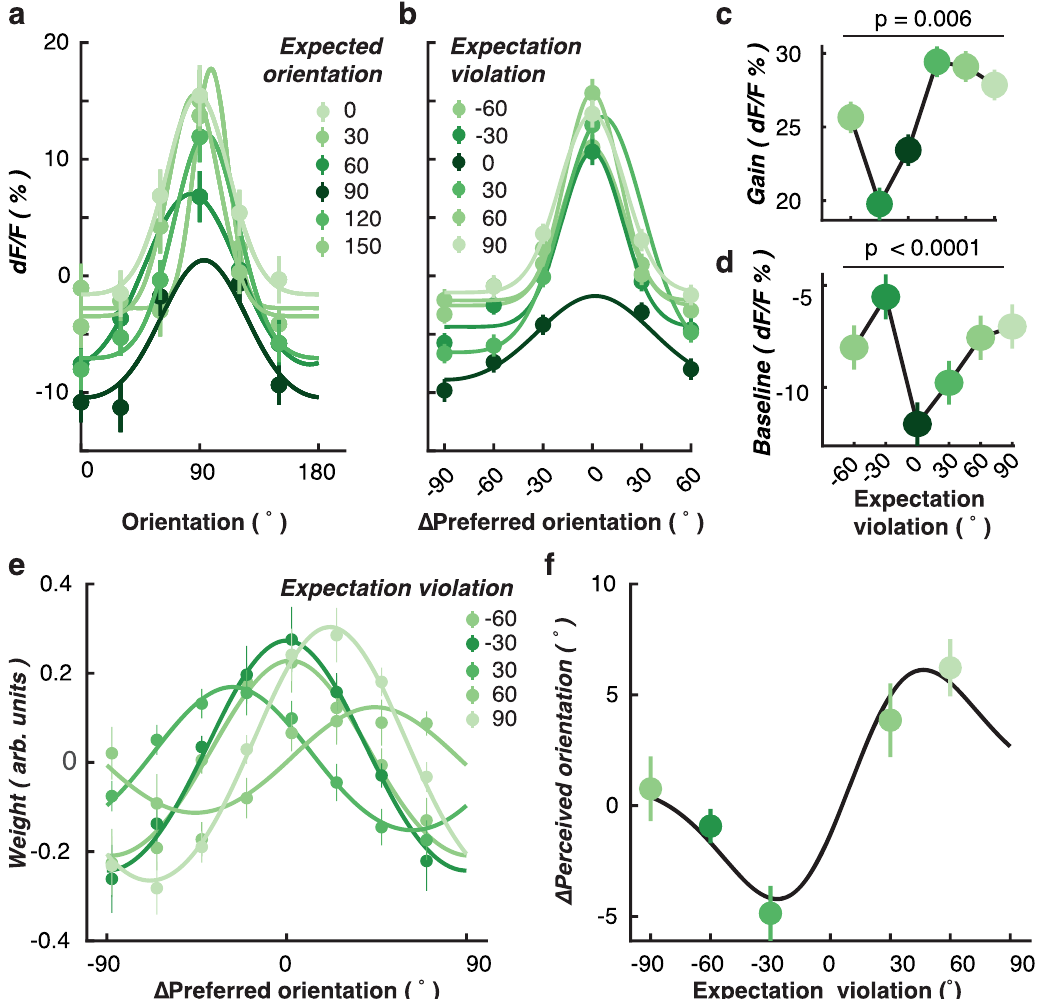
Fig. 4 | Increase in neuronal responses tounexpectedstimuliis determinedby the magnitude of the prediction error. a Neurons tuned to each displayed orientationareaffecteddifferentlywhendifferentorientationsareexpected.Panel a shows an example for each expected orientation using neurons selective for 90° orientations ( n =92 neurons), as de fi ned based on their responses in the Random condition(from250to1000ms).Responsesofremainingneuronsselectiveforthe other presented orientations are shown in Supplementary Fig. 3. For each unex- pected stimulusintherotatingcondition,weidenti fi edthe difference betweenthe orientation of the expected stimulus and the orientation of the presented unex- pected stimulus. For instance, if 60° was expected but 0° was unexpectedly pre- sented,the expectation violation wouldbe60°. b Allorientation-selective neurons ( n =462)alignedwiththeirpreferredorientation,plottedasseparateGaussiansfor